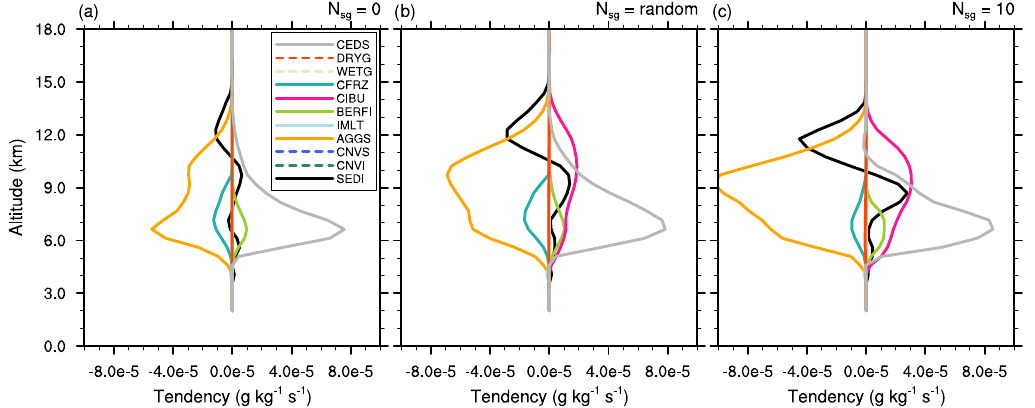
Figure 9. Mean microphysics profiles of cloud ice mixing ratio tendencies of the STERAO simulations corresponding to (a) the N sg = 0 . 0 (no CIBU) case, (b) the “RANDOM” case, and (c) the case with N sg = 10 . 0. The dashed lines are associated with processes having no significant impact on these